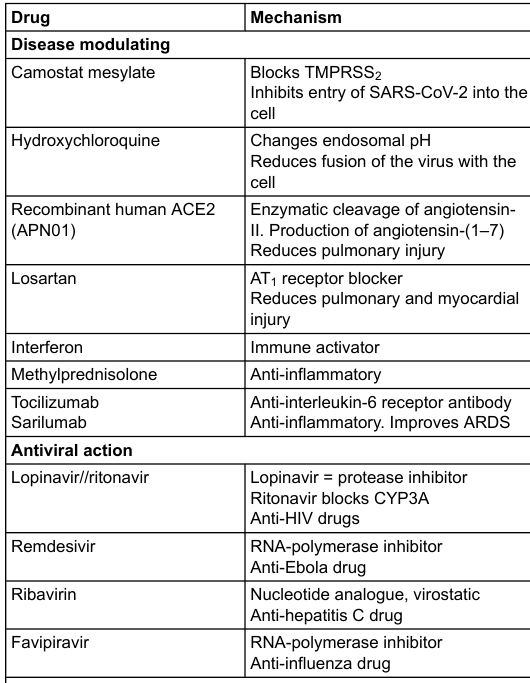
Table 2: Drugs under evaluation for COVID-19